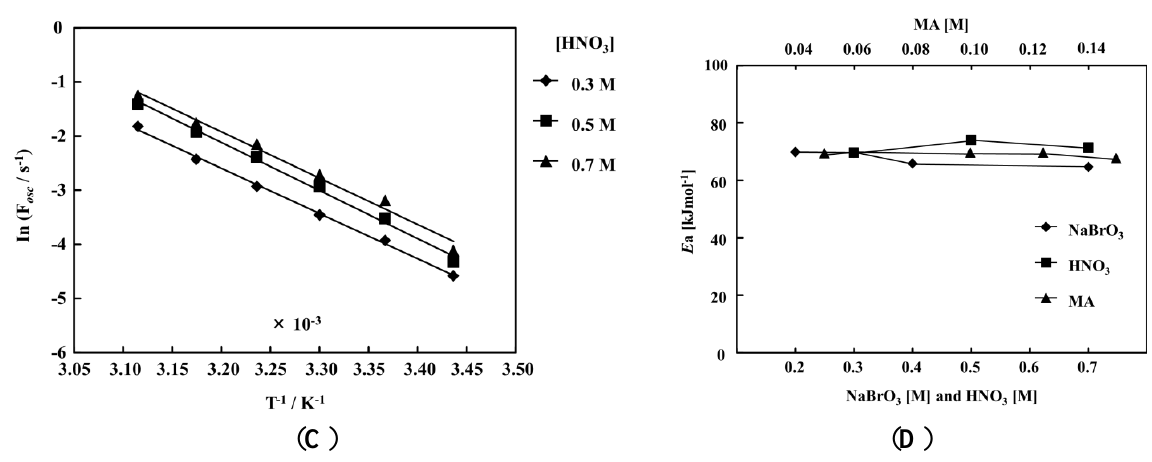
Figure 9. Arrhenius dependence on temperature of the self-oscillation of the poly(NIPAAm- co -Ru(bpy) ), F osc , with fixed concentrations of the other two BZ substrates: 3 ( A ) [NaBrO ] = 0.3 M and [HNO ] = 0.3 M; ( B ) [MA] = 0.1 M and [HNO 3 3 ( C ) [NaBrO ] = 0.3 M and [MA] = 0.1 M; ( D ) Dependence of activation energy on 3 concentration of the three BZ